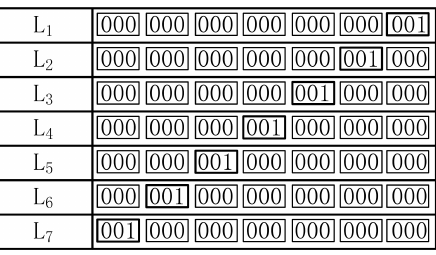
Figure 3. AE 1 of L 1 when L =